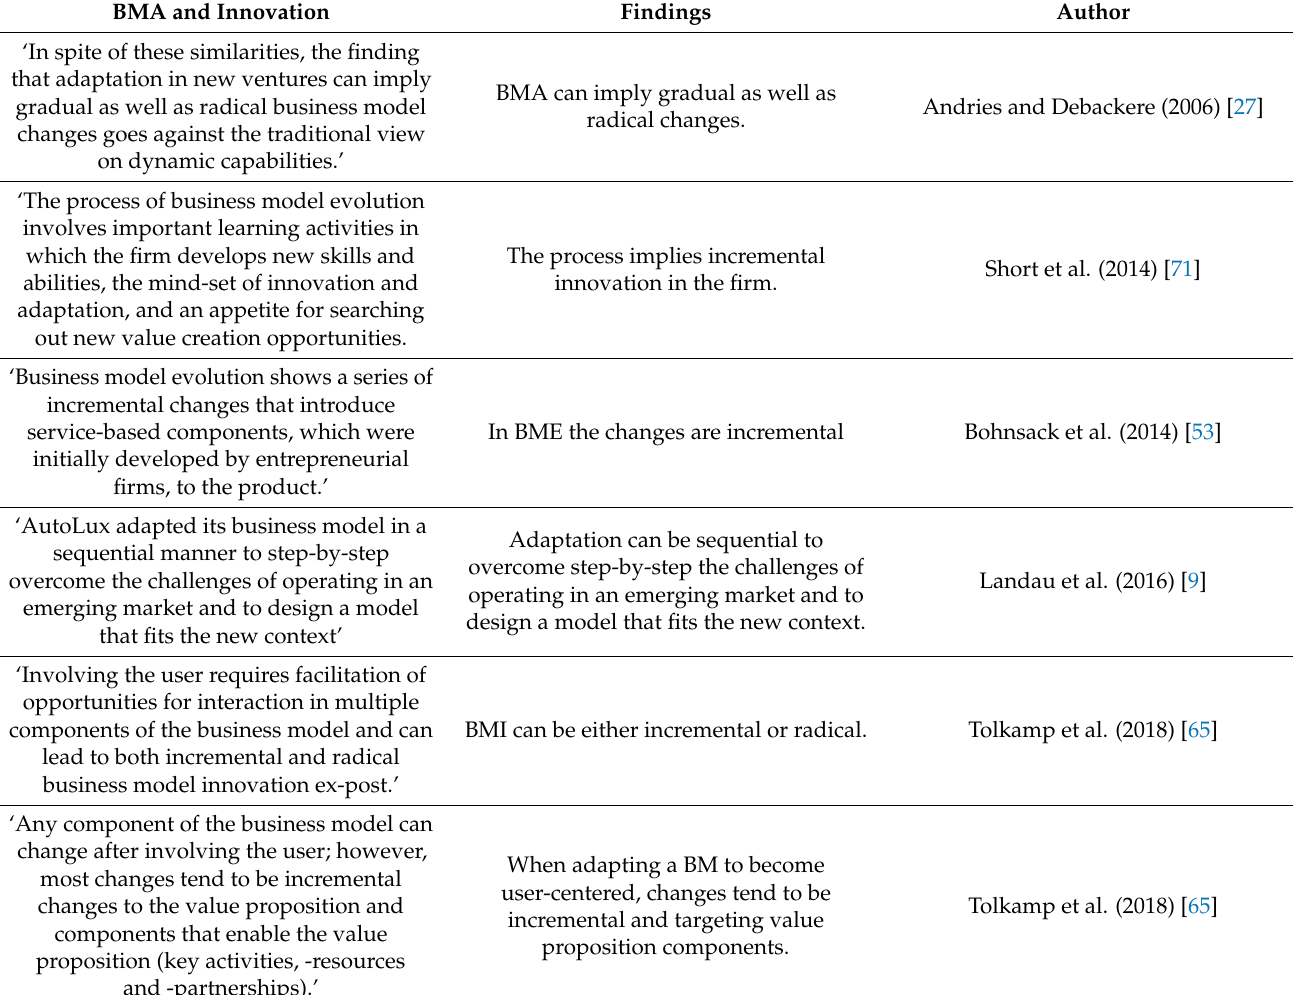
Table 8. Degree of Innovation in BME, BMA, and